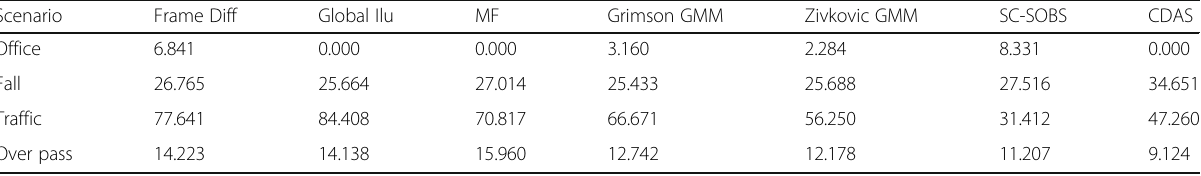
Table 9 Comparisons of FAR of the competing methods over tested scenarios